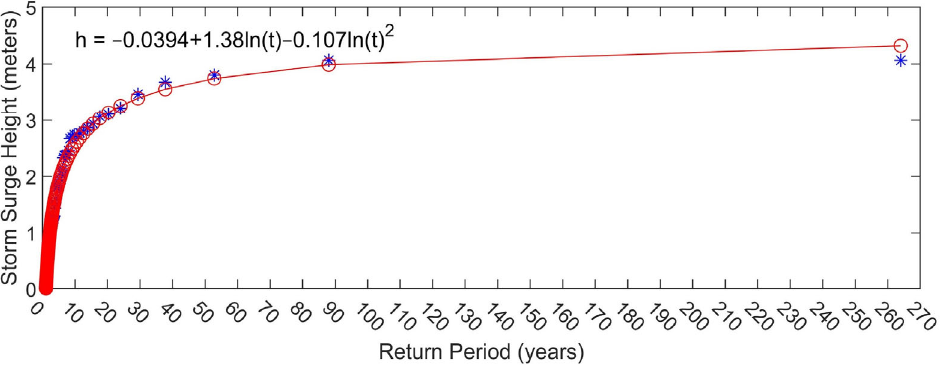
Figure 2. Storm surge height on SC coast as a function of their return periods.